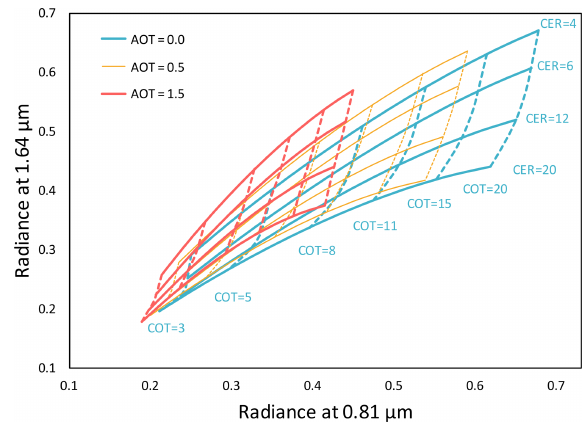
Figure 2. Simulated radiances at 1.64 and 0.81µm for clouds with varying COTs and CERs (µm), without (blue) and with (orange and red) overlying absorbing aerosols above. The viewing geometry, the aerosol and the cloud properties are the same as in Fig.